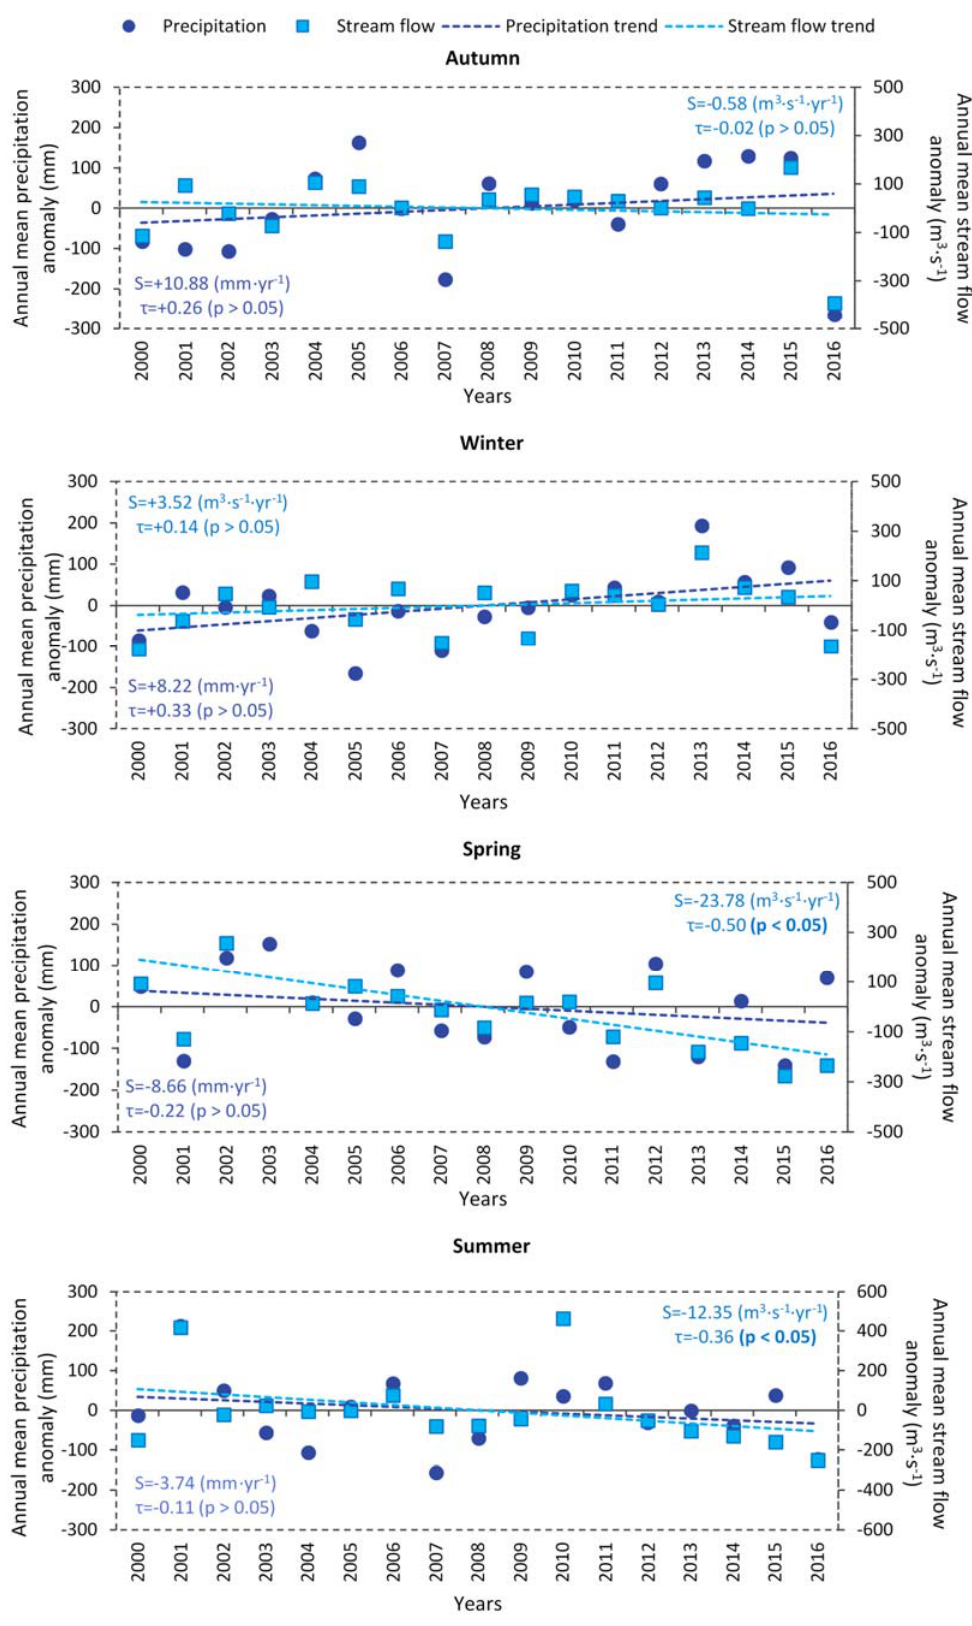
Figure 9. Anomalies of seasonal accumulated precipitation and mean stream flow for the period 2000–